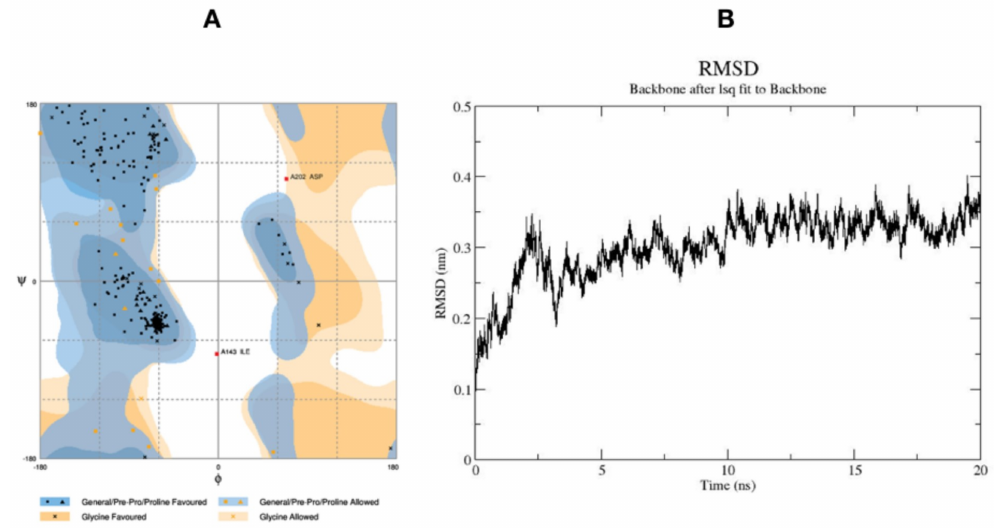
Figure 4. Ramachandran plot of generated ATR kinase model ( A ); and Molecular dynamic trajectory for 20 ns ( B